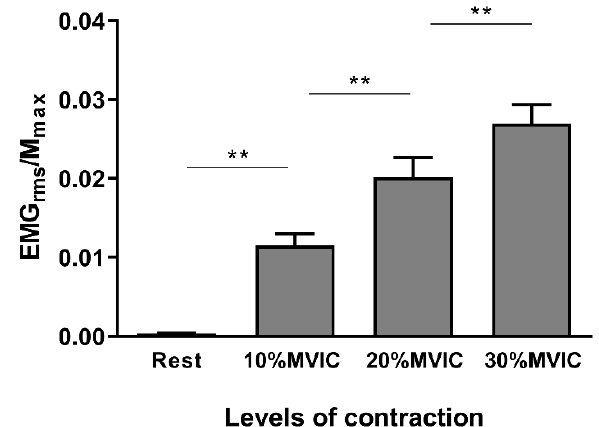
Figure 3. EMG rms / Mmax ratios pooled for MEP test (unconditioned) and MEP cond (conditioned) and the two test stimulus (TS) intensities (120% and 130% of motor threshold (MT)). EMG rms were recorded 100 ms before the delivery of each TMS pulse. ** p < 0.01